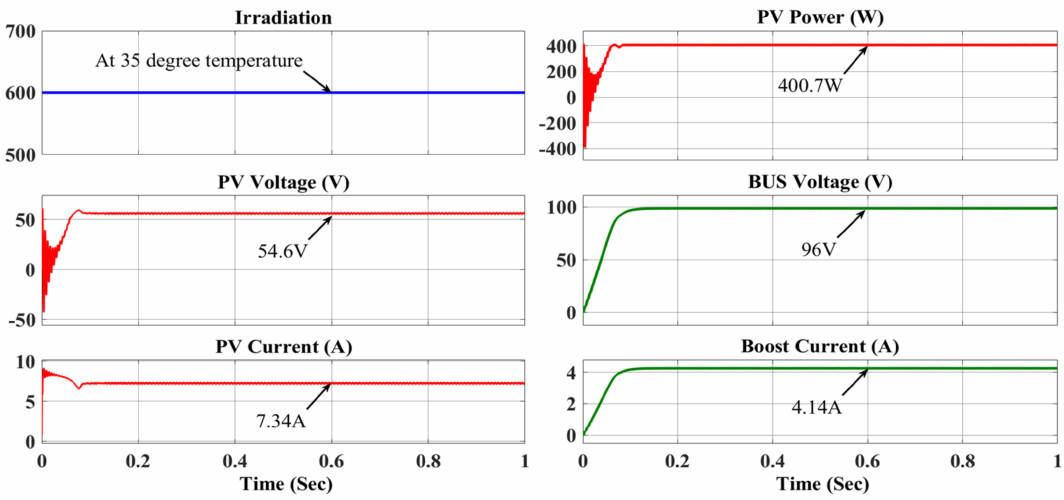
Figure 11. PV measurements, boost voltage, current, and PV output power at an irradiance of 600 W/m 2 and temperature of 35 ◦ C for PV 2 .